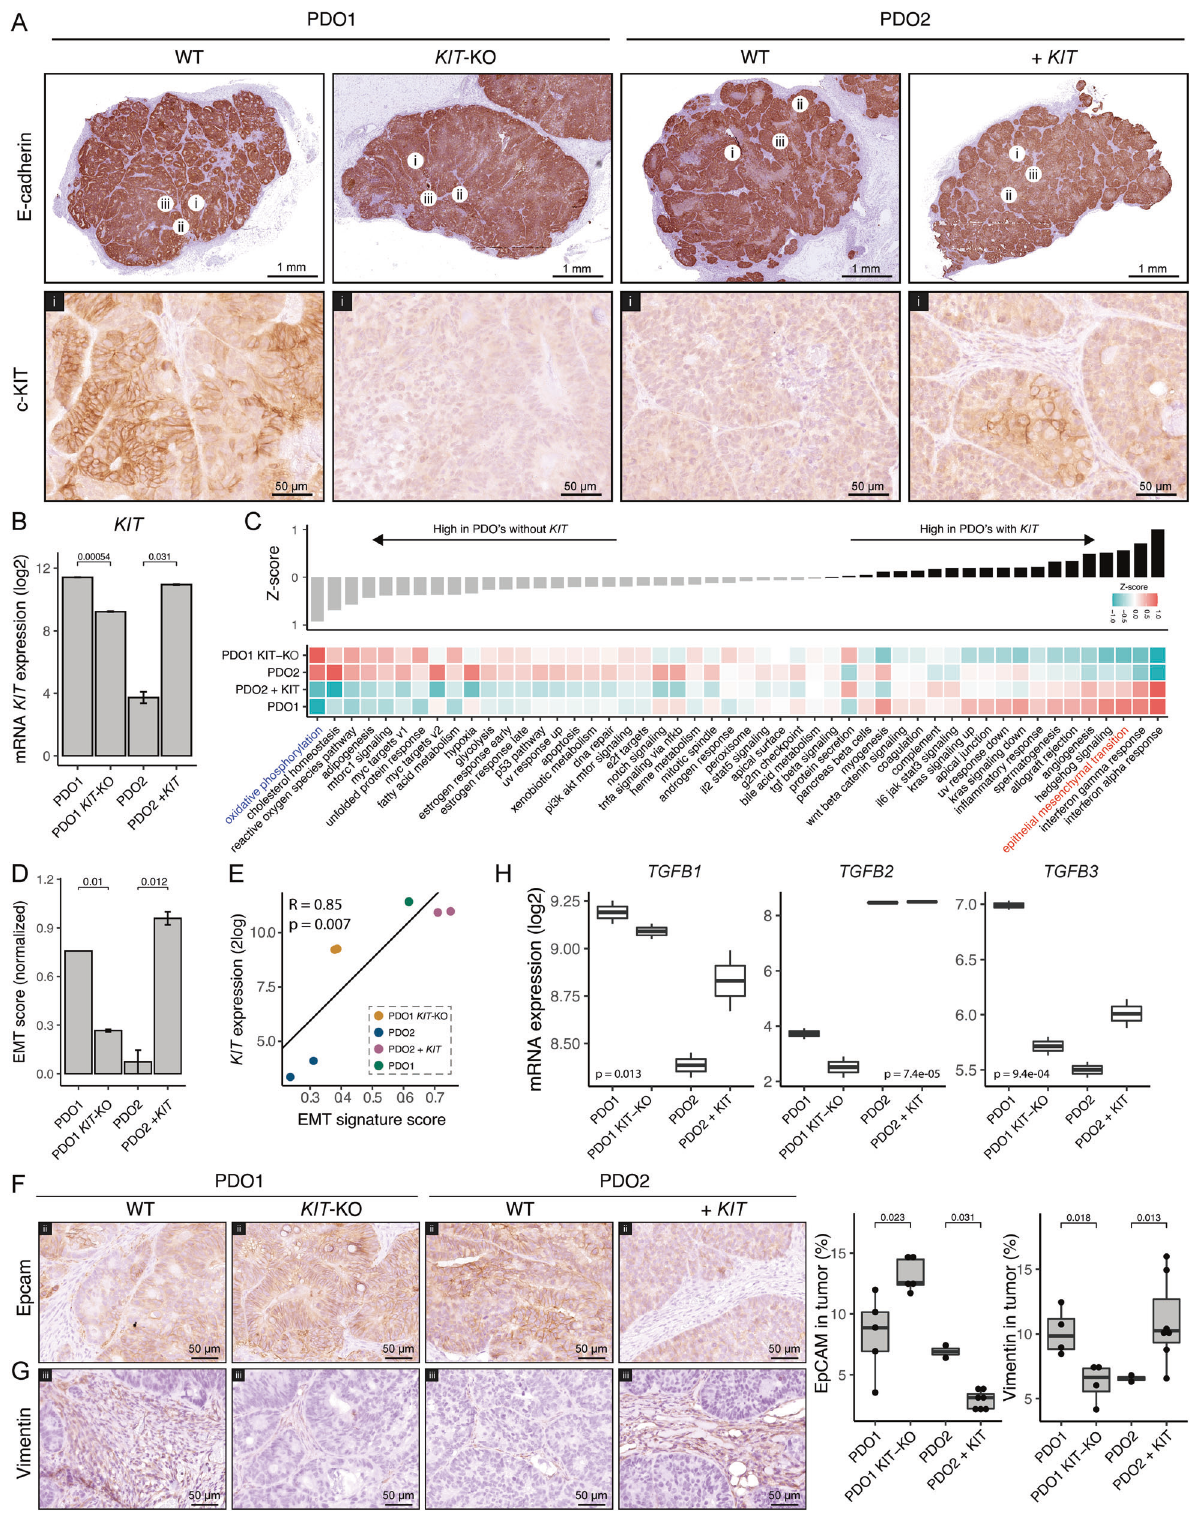
Fig. 3 KIT induces stroma formation in PDO-initiated subcutaneous tumors in NSG mice. A Histological overview of PDO1 CONTROL , PDO1 KIT-KO , PDO2 CONTROL , and PDO2 KIT initiated subcutaneous (s.c.) tumors in NSG mice ( n = 2 per group). Expression of epithelial-junction marker E-cadherin and cell-surface KIT are shown. Circles with numbers indicate the region of zoom-in images. Scale bar for E-cadherin is 1mm and for KIT 50 µm. B mRNA level of KIT in s.c. tumors. C Gene set enrichment analyses of hallmark signatures for the s.c. tumors, ranked based on Z-score. D Barplot showing the hallmark EMT signature score for each s.c. tumor. E Scatter plot showing positive correlation with KIT expression and EMT score for s.c. tumors. F Histological images of a epithelial marker EpCAM and ( G ) stroma-marker Vimentin in s.c. tumors. Box plots show the quanti fi ed expression of EpCAM and Vimentin in a s.c. tumors ( H ) mRNA levels of TGFB1-3 ligands in s.c. tumors. An unpaired t-test was applied to assess the signi fi cance between the groups. Cell Death and Disease (2022)